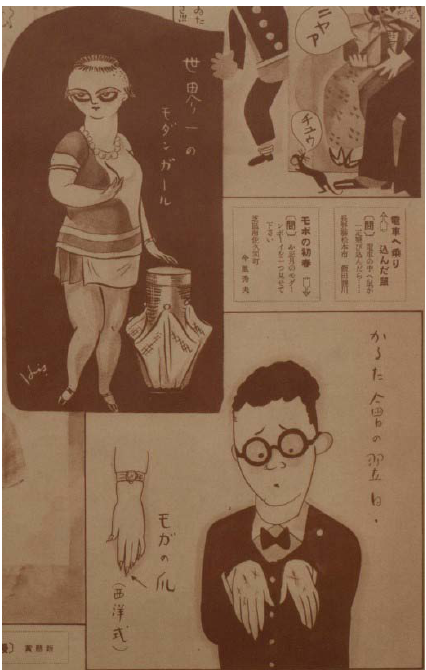
Figure 4. Asahi Gurafu [Asahi Graphic], 1928, vol. 10, no. 2: 8. The threatening figure of the modern girl is juxtaposed with the wounded modern boy who bears scars on his hands from her claw-like